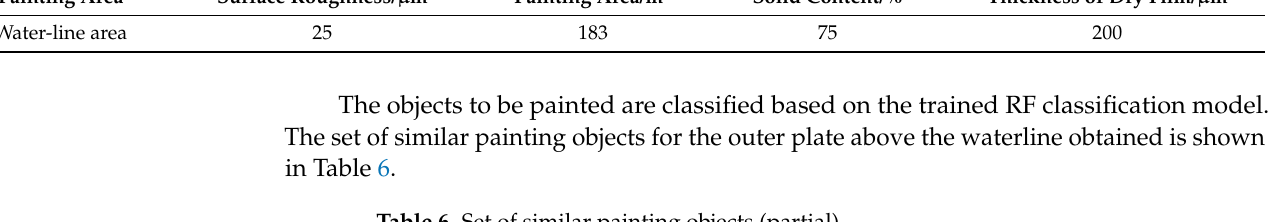
Table 6. Set of similar painting objects (partial).